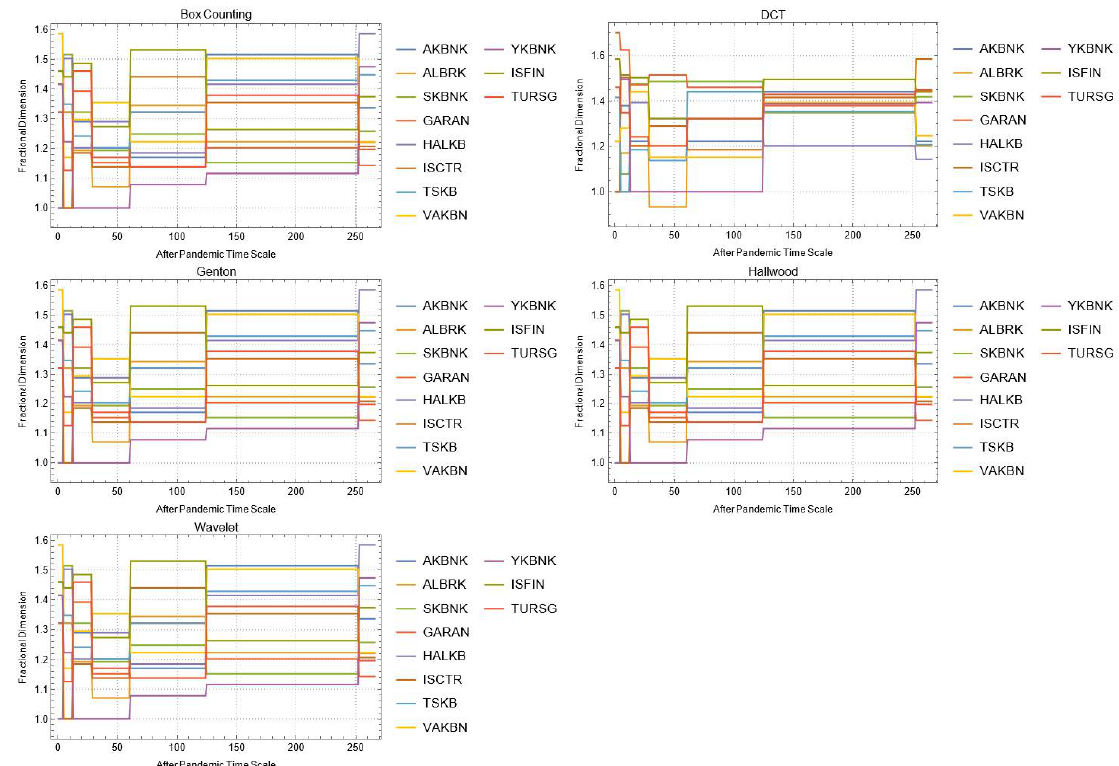
Figure A24. Daily changes of fractal dimensions after the pandemic (financials).